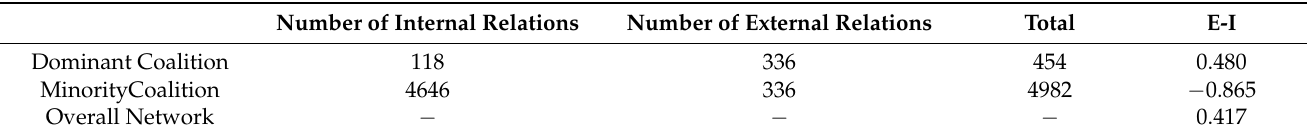
Table 6. E-I index of networks